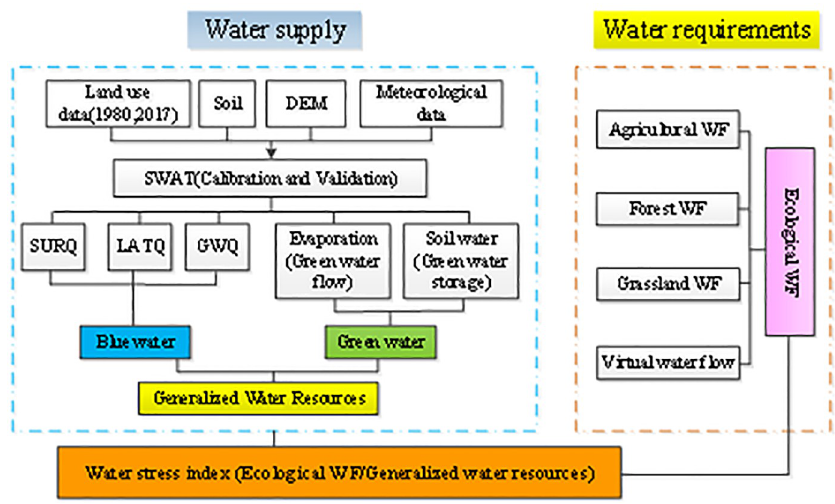
Fig 2. Framework for assessing the ecological water stress in the Yanhe River